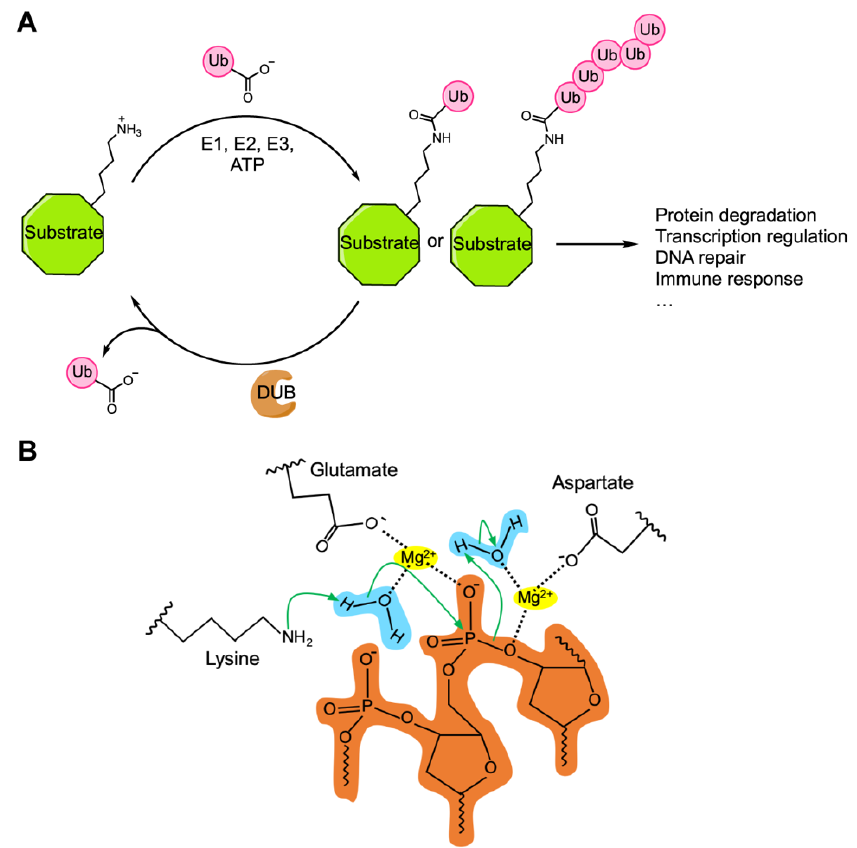
Figure 2. ( A ) Summary of the ubiquitin system. In eukaryotes, the small protein modifier ubiquitin (Ub) can be covalently attached to a nucleophilic residue of its protein substrate by the combined actions of the E1 ubiquitin-activating enzyme, an E2 ubiquitin conjugating enzyme, and an E3 ubiquitin ligase in an ATP-dependent manner. Polyubiquitin chains can form when a ubiquitin is further modified by other ubiquitin molecules. Ubiquitin modification is reversed by the enzymatic activity of deubiquitylases (DUBs). ( B ) Mechanism of PD-(D / E)xK nucleases. Catalytic aspartate and glutamate coordinate two magnesium ions (yellow) that bring two water molecules (blue) near the cleavage site. Catalytic lysine deprotonates and activates one of the water molecules, which then serves as a nucleophile that attacks the DNA phosphate backbone (orange). The second water molecule, along with the two magnesium ions, help stabilize the reaction intermediate. Green arrows represent electron pair movements.